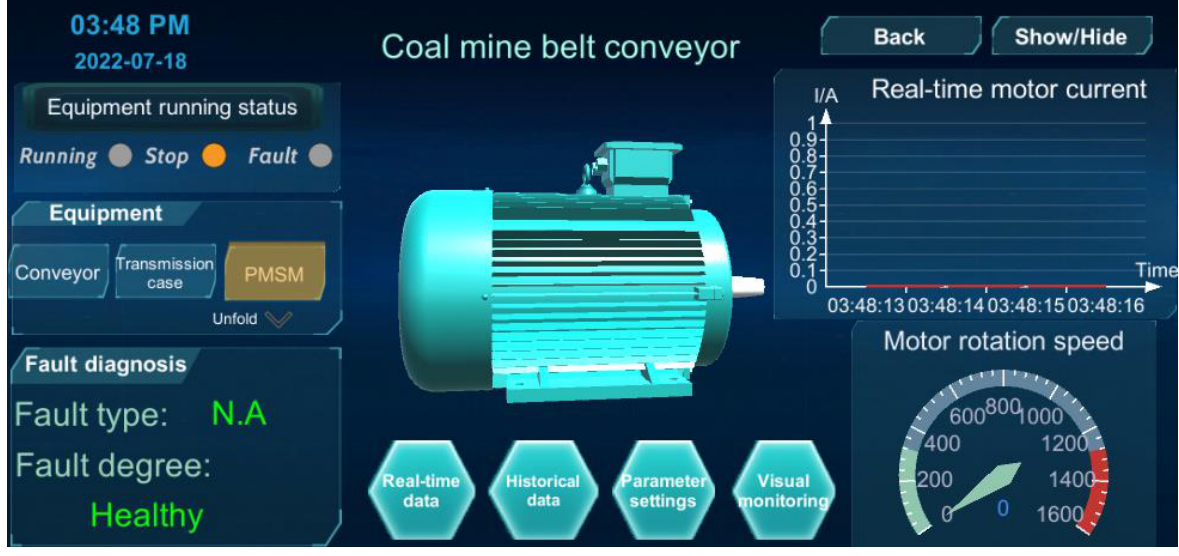
Figure 12. Digital twin visualization interface.